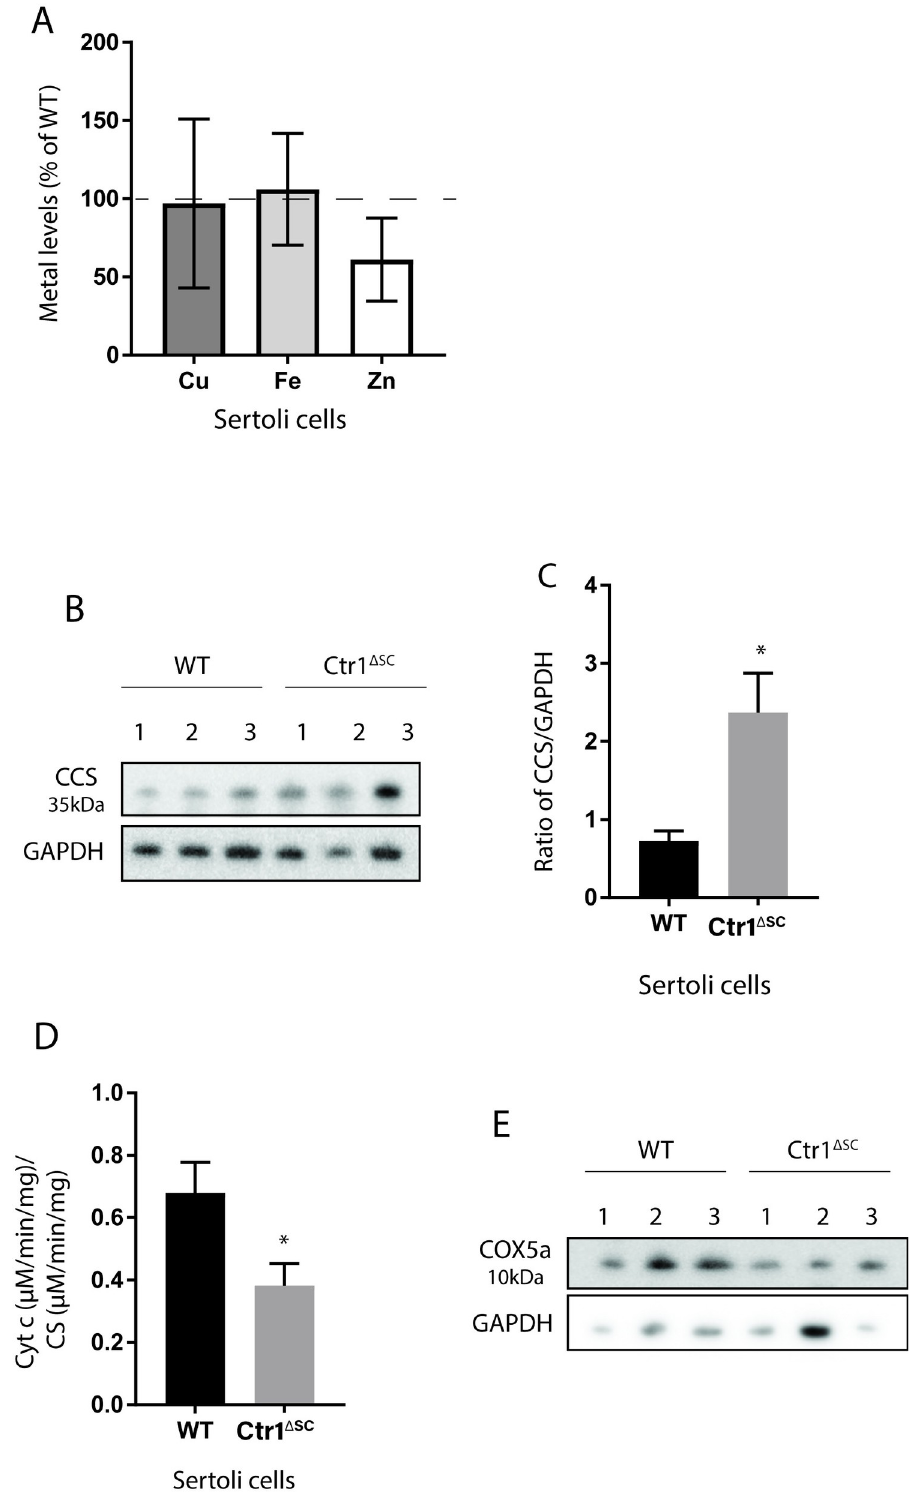
Fig 6. Loss of CTR1 in Sertoli cells display normal copper levels but copper deficient phenotype. (A) Relative Cu, Fe and Zn levels in primary SCs isolated from WT and Ctr1 Δ SC testes. Data represents percent concentration ( μ g of metal per 10,000 cells) of Ctr1 Δ SC SCs compared to WT SCs. Dashed line represents 100% of each metal in WT SCs.